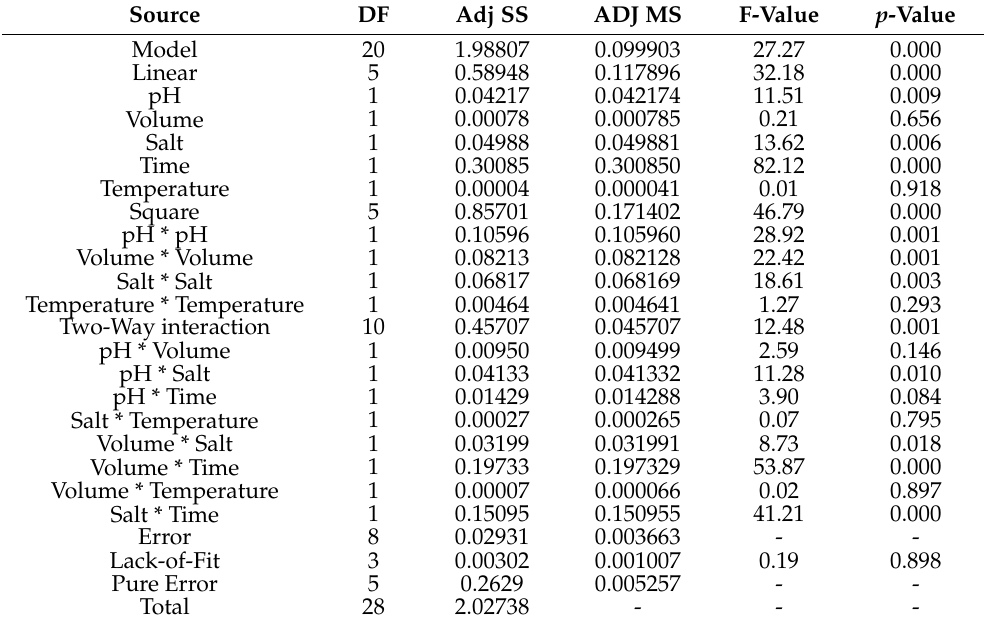
Table 4. Analysis of variance of cotton fabric for RV 05